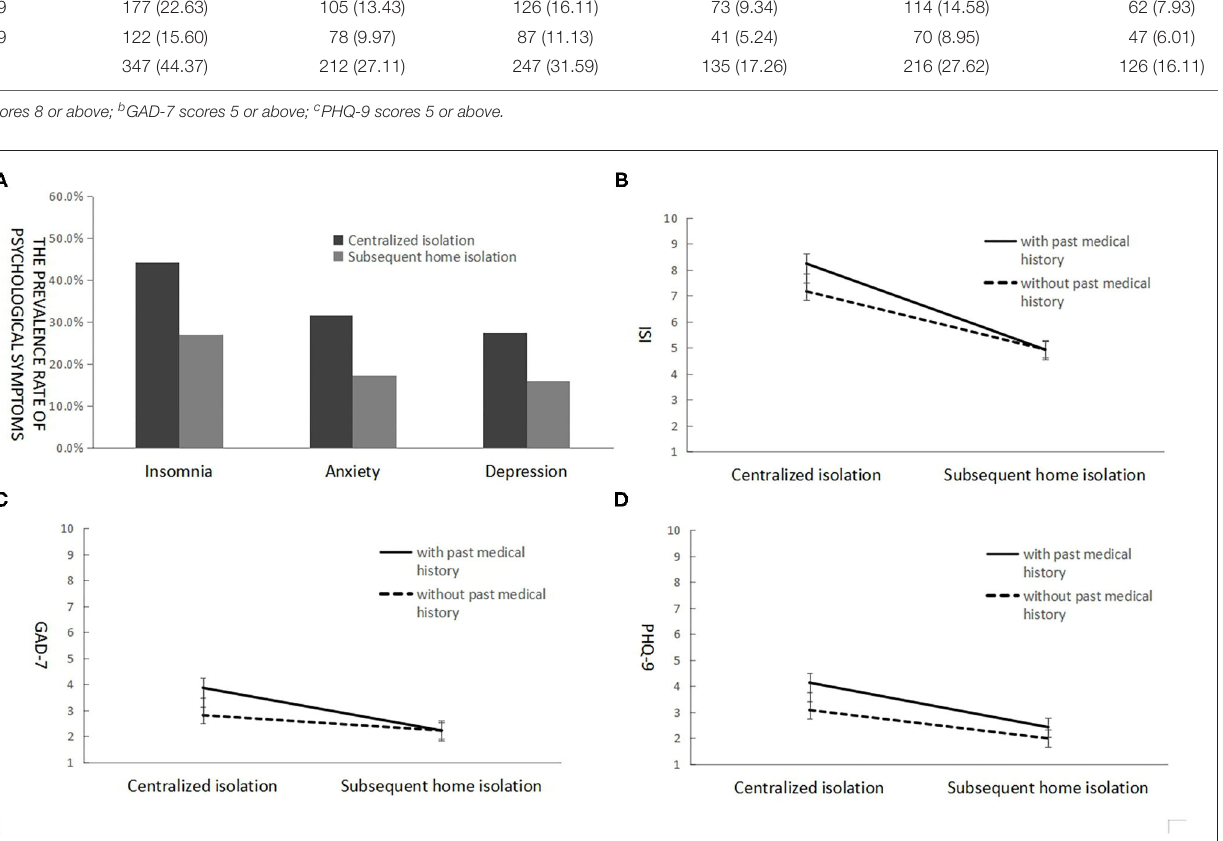
FIGURE 1 | The prevalence rate of mental symptoms among the discharged COVID-19 patients during the first month of centralized quarantine and home isolation (A) , with the scores of insomnia (B) , anxiety (C) , and depression (D) depending on quarantine status and previous medical